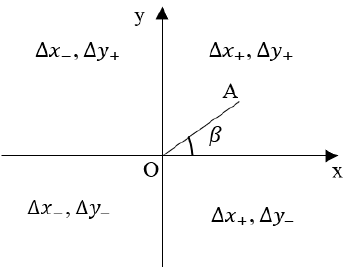
Figure 8. The distribution of mechanical displacement error.